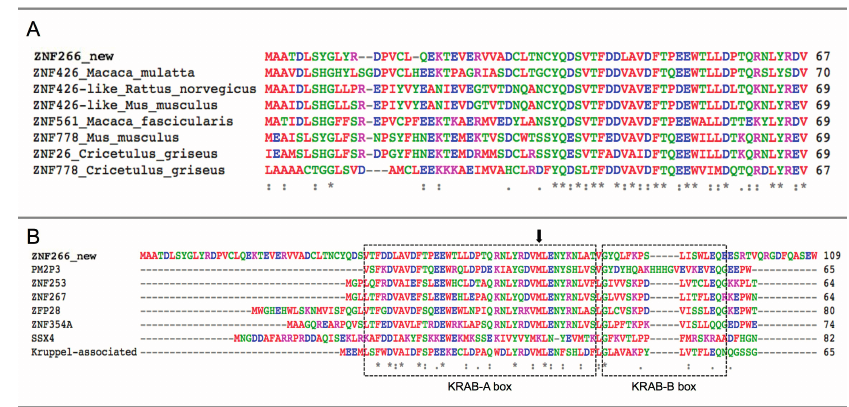
Figure 4. Multiple alignment of the N -terminal residues of the novel predicted ZNF266 variants. The evolutionary conservation of the new 67 amino acids is shown in ( A ); Krüppel-associated box (KRAB)-A and -B boxes (dashed lines) alignment with other human genes is shown in ( B ). Identical residues are indicated by “ * ”, conservation between groups of strongly and weakly similar properties by “:” and “.” respectively. Black arrow indicates the start of the canonical ZNF266 protein isoform.